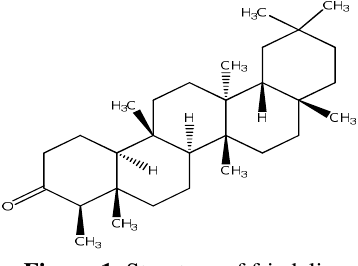
Figure 1. Structure of friedelin